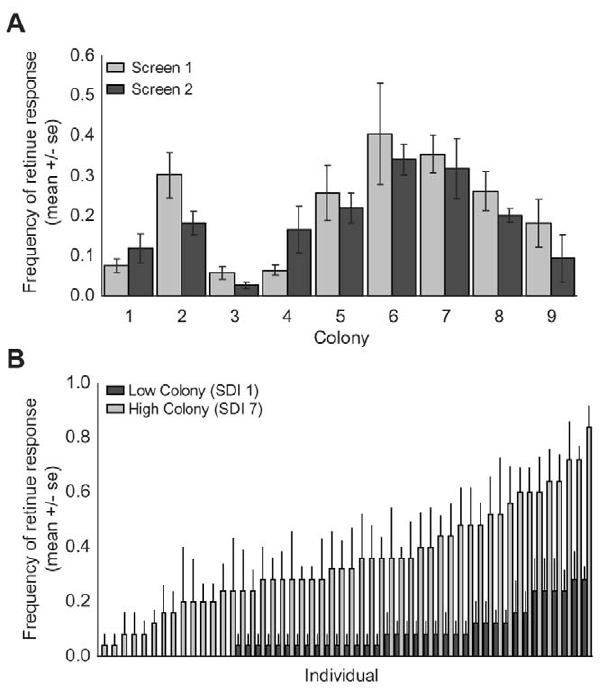
Figure 1. Retinue response varies among colonies and among individuals within a colony. A . 9 SDI colonies were screened for retinue response. There were strong differences among colonies in mean retinue response frequency (p , 0.0001). There was a significant effect of day on colony response (p=0.003), but no significant effect of the time of the screen (p=0.09), cage (p=0.14), or any significant colony by day (p=0.10) or colony by screen (p=0.42) interaction. B . Based on the results of the previous screens, two A.m. carnica colonies were selected for the subsequent molecular and physiological analyses. The previous retinue bioassay was modified to measure individual variation in response to QMP. There were significant individual differences in retinue response frequency among individuals in both colonies (p , 0.001).